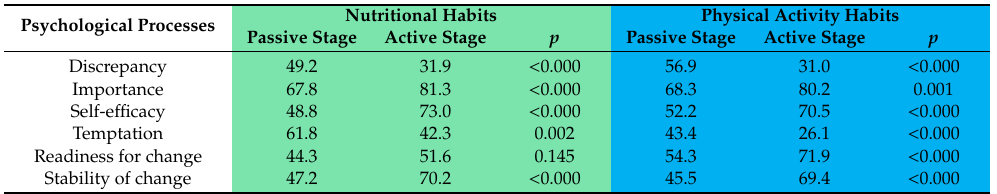
Table 5. Mean scores of aggregated stages of change for psychological processes according to nutritional and physical activity